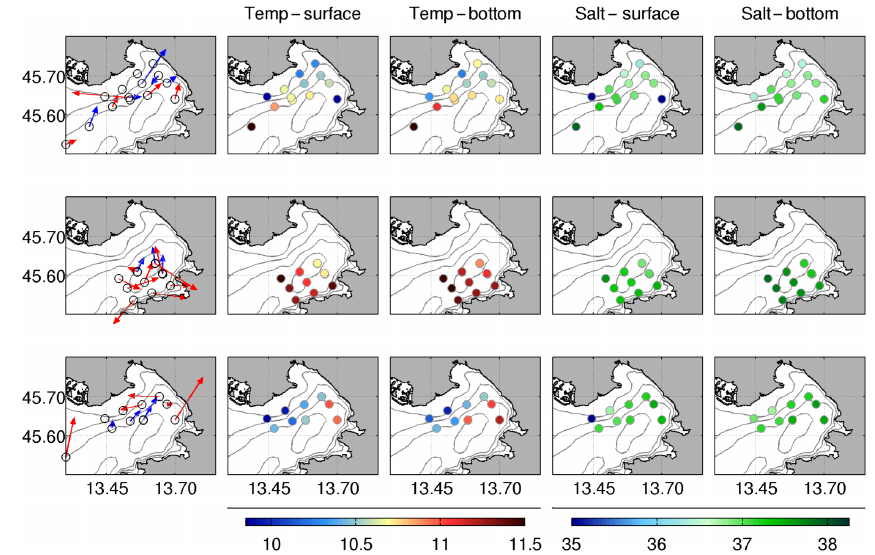
Figure 3. Bottom currents and values from CTD casts at surface and bottom are shown inside the GoT for 30 January (top panels), 31 January (central panels) and 4 February (bottom panels). Panels on the left column show the ADCP bottom cell currents; red arrows are observations taken during rising tide, blue arrows during falling tide. Temperature (second and third columns) and salinity (fourth and fifth columns) values are shown for surface (0 and 2.5m) and bottom layers (last 2.5m of cast) inside the GoT.